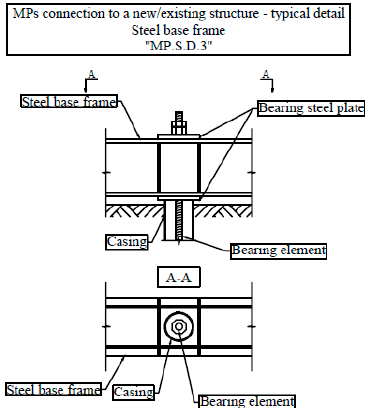
Figure 13. MP connection to a new/existing steel base frame—typical detail (after [1]).